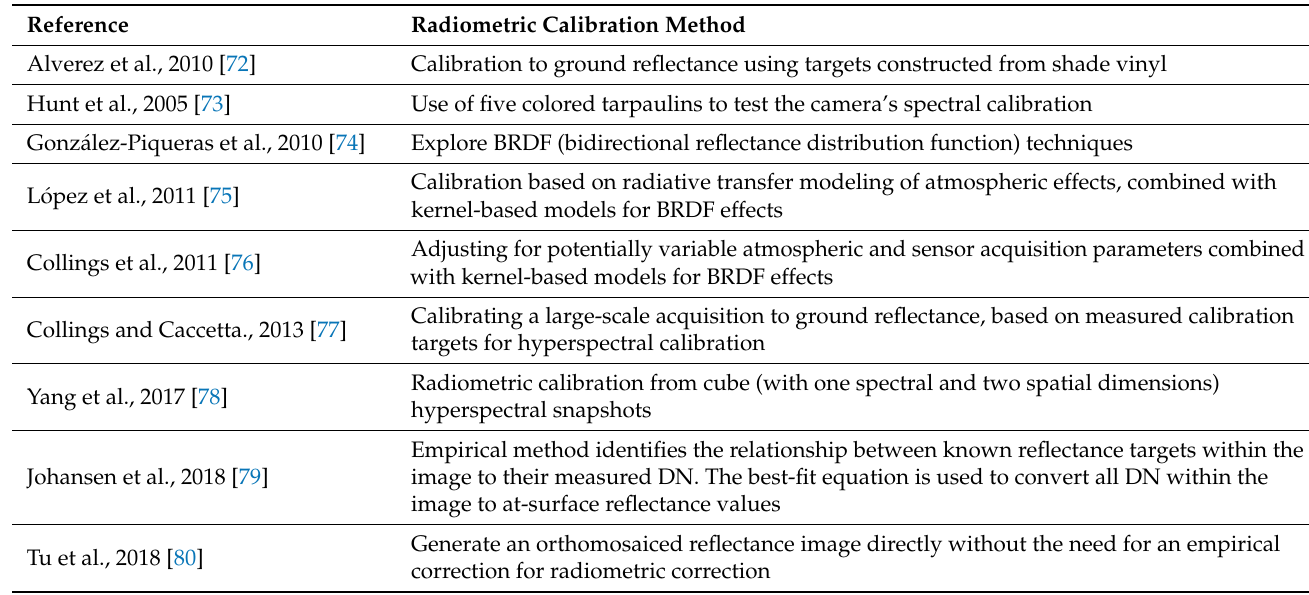
Table 7. Proposed radiometric correction method in research